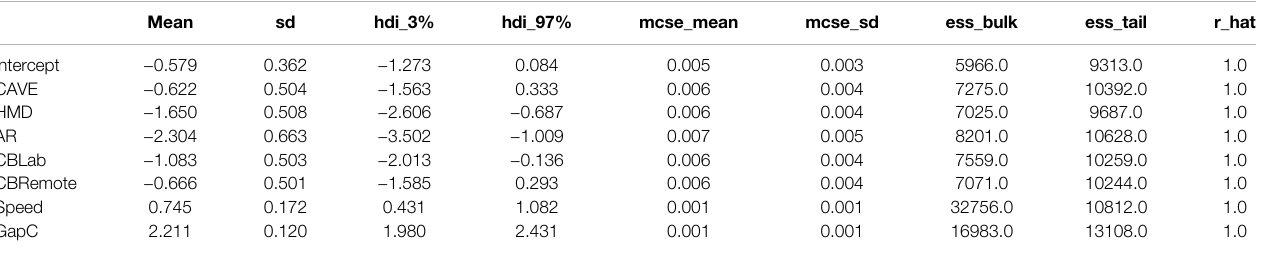
TABLE 2 | Summary for crossing model: Crossing ∼ Condition + Speed + GapC +(1| ID ). REAL served as a baseline. GapC refers to the centered gap size variable [ − 2s, 2s] rather than [1s, 5s]. Mean sd hdi_3% hdi_97% mcse_mean mcse_sd ess_bulk ess_tail r_hat Intercept − 0.579